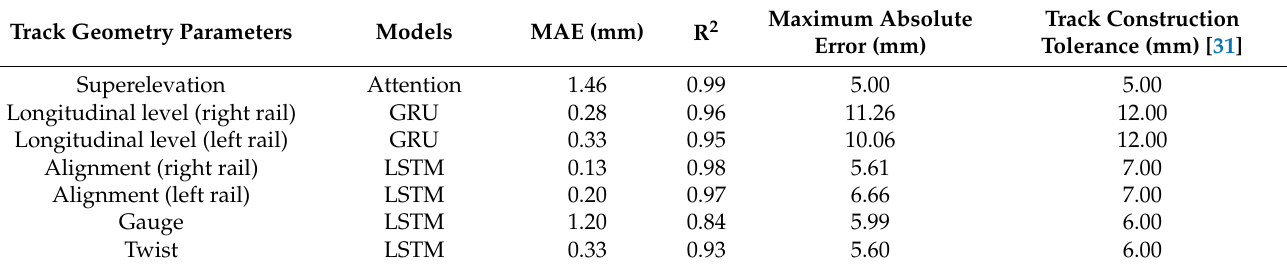
Table 5. The best performance to predict each track geometry